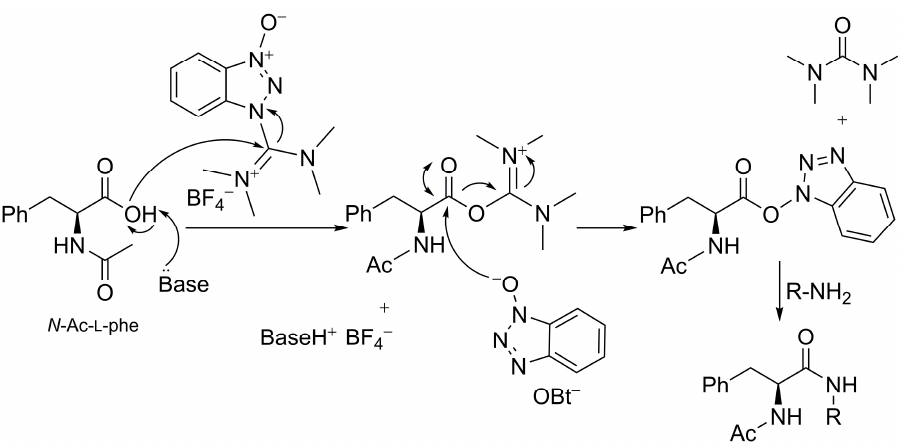
Figure 2. Hypothesized mechanism of N -Ac- L -phe activation and amidation using TBTU and a tertiary base.